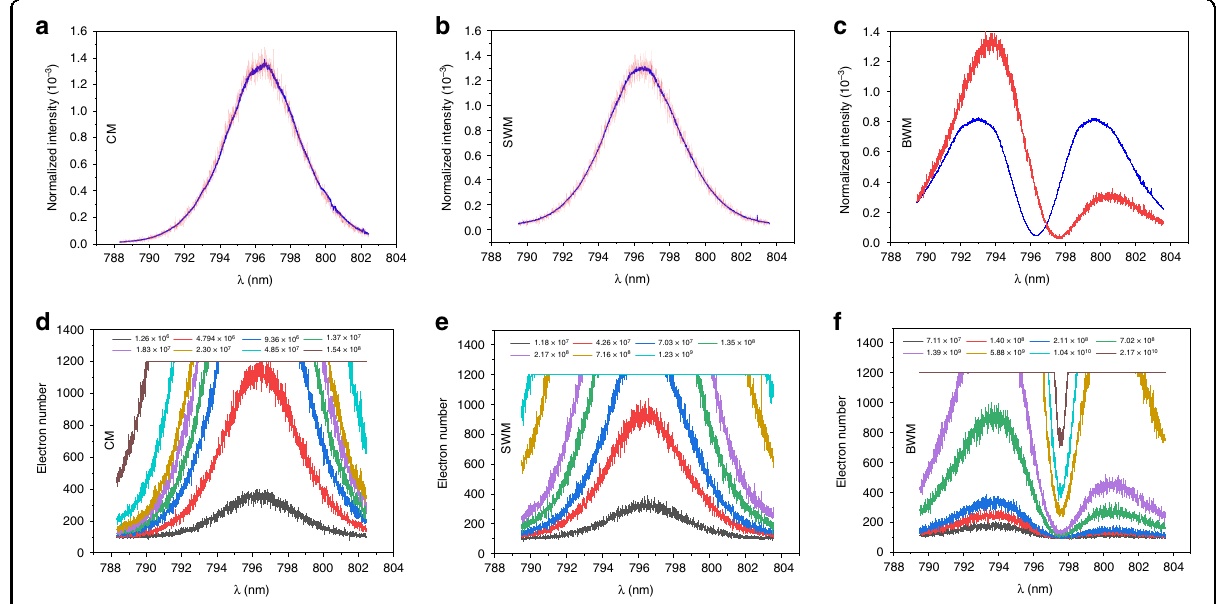
Fig. 4 Spectrum distribution in CM, SWM, and BWM schemes. The spectrum re- distributions of a CM, b SWM, and c BWM are shown when the magnetic fi eld is turned on. Here, blue and red curves represent the spectrum distribution before and after turning on the magnetic fi eld. In d – f the electron number redistributions for CM, SWM, and BWM are shown for varying numbers of the incident photon. Typically, a larger photon number leads to more pixels becoming saturated in the CMOS. For CM and SWM, nearly all the pixels saturate when n approaches 10 8 and 10 9 , and then the CMOS outputs a fl attening pro fi le, which limits the precision of the two protocols. By contrast, BWM is more robust to DSE because there is an ultra- sensitive extinction point, which is dif fi cult to saturate even for 10 10